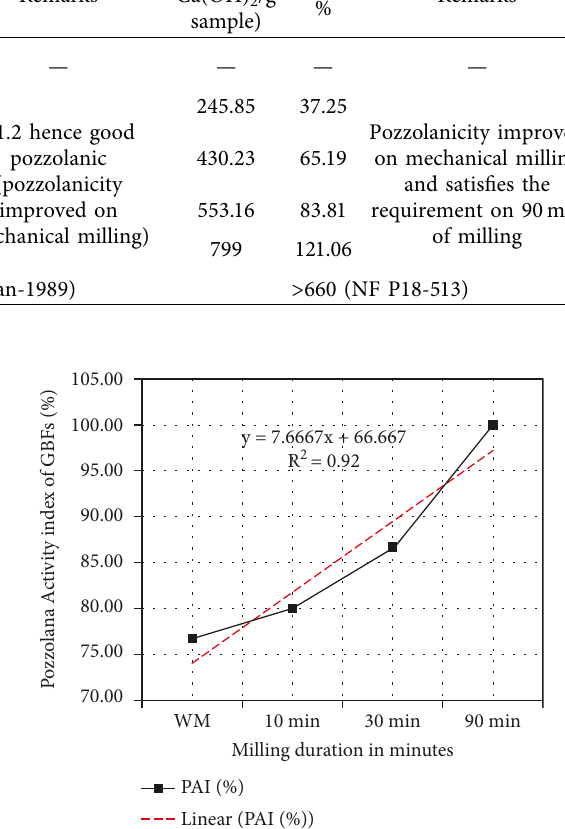
Figure 8: Pozzolanic activity index of GBFS.